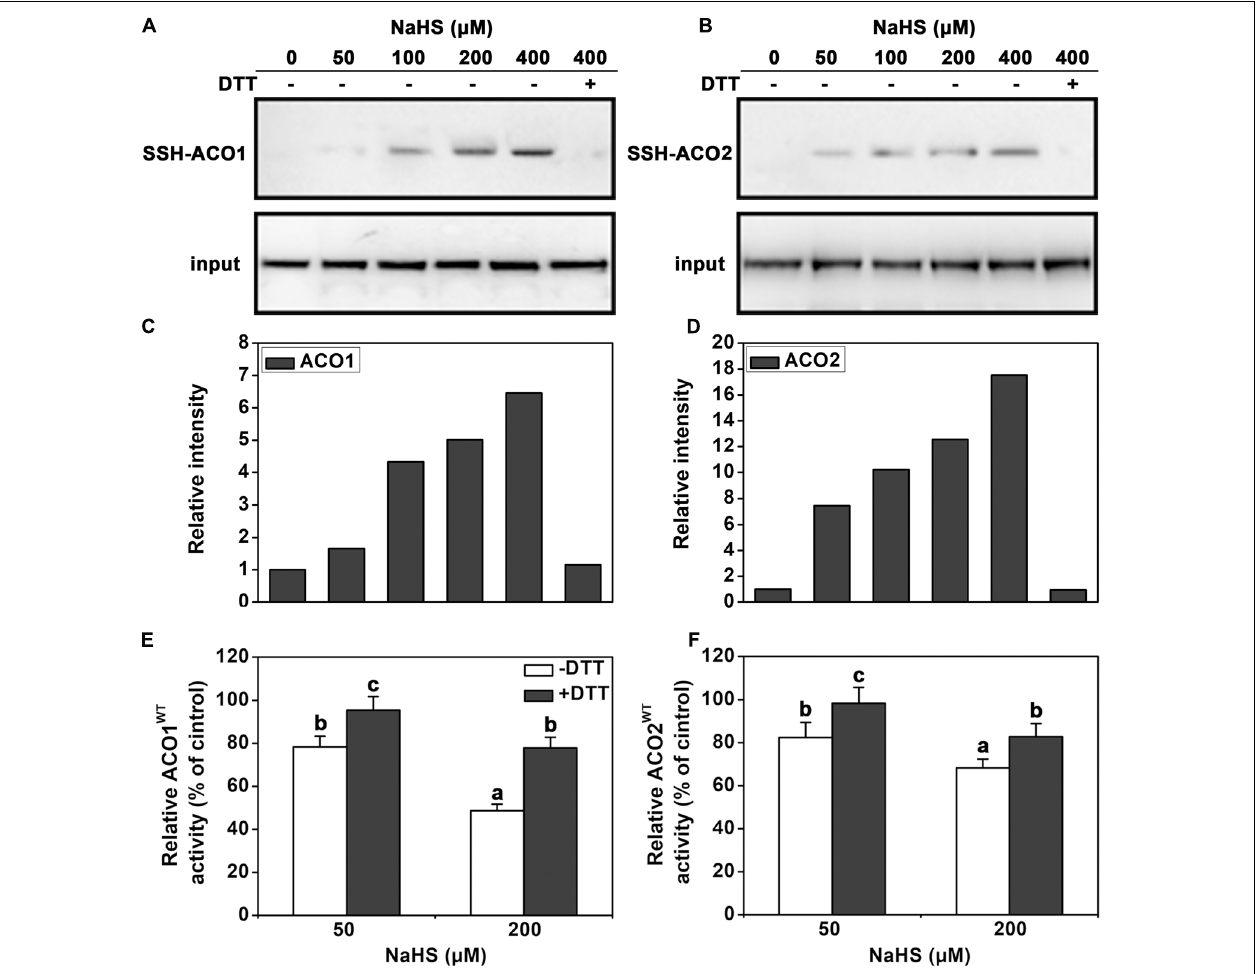
FIGURE 4 | Immunoblot and activity analysis of recombinant LeACO1 and LeACO2 proteins. (A) NaHS-induced persulfidation of LeACO1 was detected using a MBST. (B) Quantification of persulfidation levels that are shown in (A) . (C) NaHS-induced persulfidation of LeACO2 was detected using a MBST. (D) Quantification of persulfidation levels that are shown in (C) . Input is anti-his signal, which indicate the total protein amount. Persulfidated proteins were labeled with biotin and analyzed using an anti-biotin antibody. Total proteins were analyzed using an anti-his antibody. Effect of NaHS-induced persulfidation on LeACO1 (E) and LeACO2 (F) activity. Recombinant proteins were pretreated with NaHS and NaHS plus DTT (10 mM) for 20 min, and then the immunoblot analysis carried out. Mean values ± SE are calculated from three replicates. Within each set of experiments, bars with different letters are significant different (Duncan’s multiple range tests, P < 0.05).